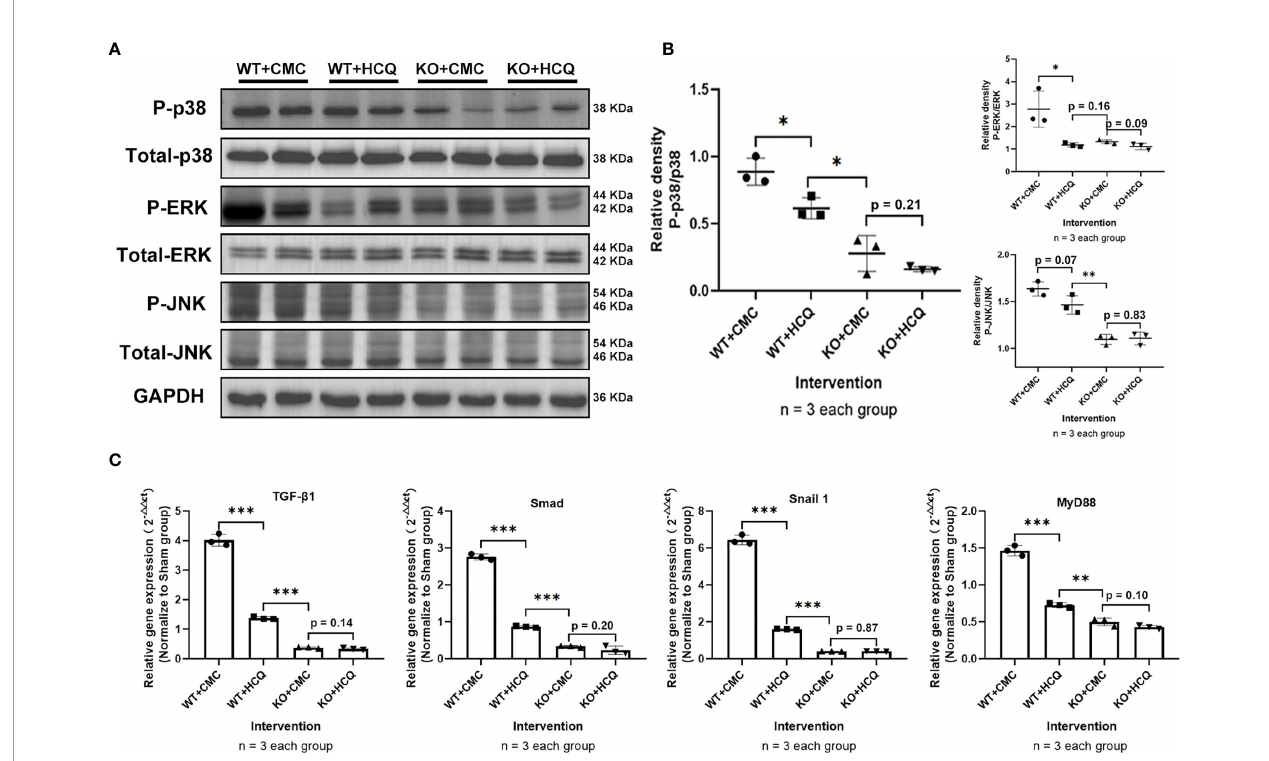
FIGURE 6 | Depletion of TLR-9 attenuates renal fi brosis following IRI through the inhibition of MAPKs and pro-in fl ammatory chemokine/cytokine induction in vivo . Renal tissues were acquired on day 21 following IRI. (A) Activations of MAPKs. (B) Semiquantitative analysis of the activation of MAPKs. (C) Expression of pro- in fl ammatory chemokines/cytokines. Data are shown as means ± SD and analyzed using one-way analysis of variance. Each dot represents an individual mouse. *P < 0.05, **P < 0.01, ***P < 0.001. IRI, ischemia-reperfusion injury; WT, wild-type; KO, knockout; MAPK, mitogen-activated protein kinase; HCQ, hydroxychloroquine; CMC, carboxymethyl